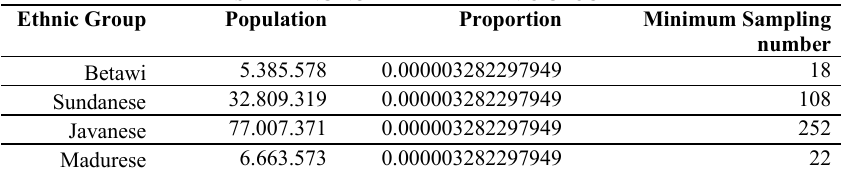
TABLE 1. SAMPLING NUMBER PER-ETHNIC